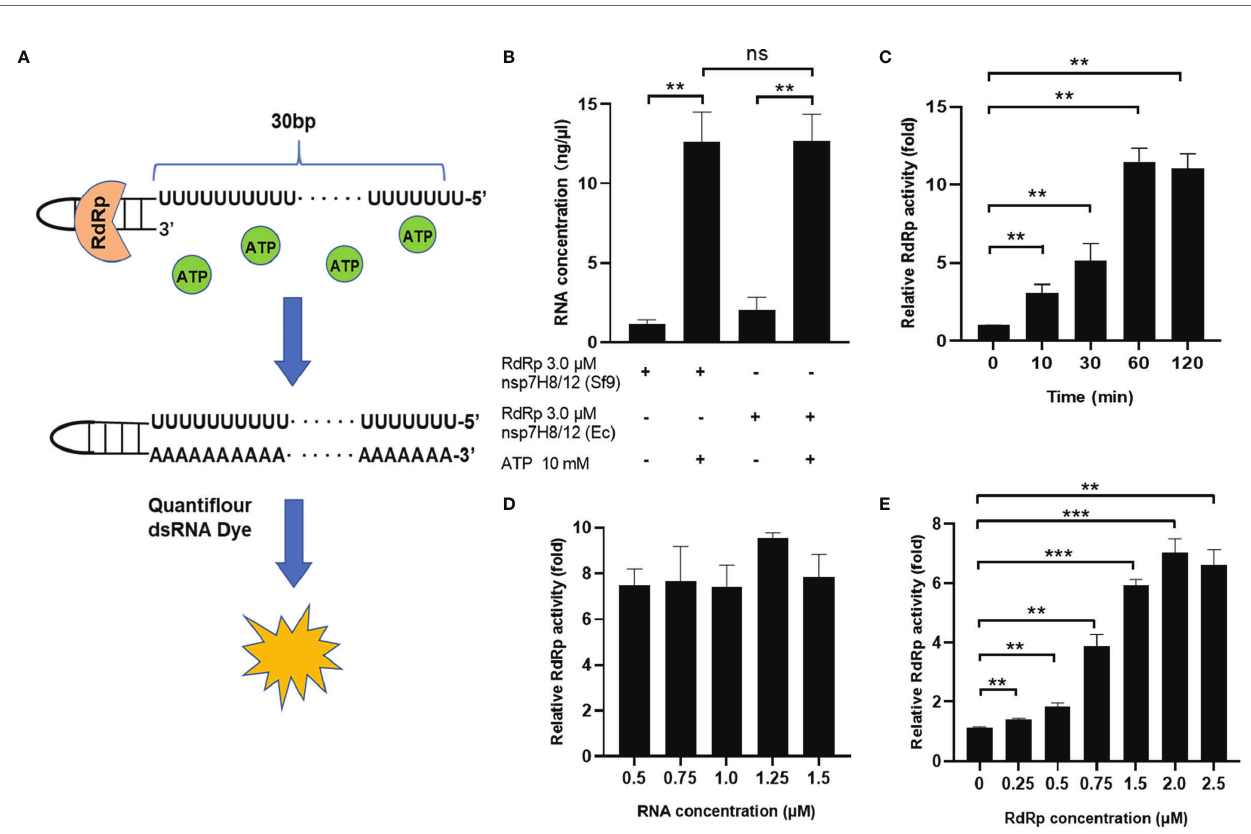
FIGURE 4 | Development of a fl uorometric RdRp assay with self-priming RNA. (A) Schematic diagram illustrating the fl uorometric RdRp assay with self-priming RNA. The self-priming RNA-labeled 5 ’ -biotin contains a 20-nt self-complementary base pairing region and a 20-nt RNA template (Ux20). RdRp activity detection assay is based on quanti fi cation of dsRNA by a fl uorometric approach. The reaction system of RdRp catalytic primer extension was set up in a 96-well plate. (B) Activity of different RdRp preparations in the fl uorometric RdRp activity assay. RdRp activity assay with optimized conditions including extension time (C) , RNA primer concentration (D) , and RdRp complex concentration (E) . The concentrations of dsRNA are assessed by the QuantiFluor dsRNA system (Promega) and normalized by dsRNA concentrations of negative control (without ATP). Data are presented as the mean ± SEM. Statistical signi fi cance was analyzed using one- tailed Student ’ s t -test. ** p < 0.01; *** p < 0.001; ns, no signi fi cance. The data are representative of at least three independent